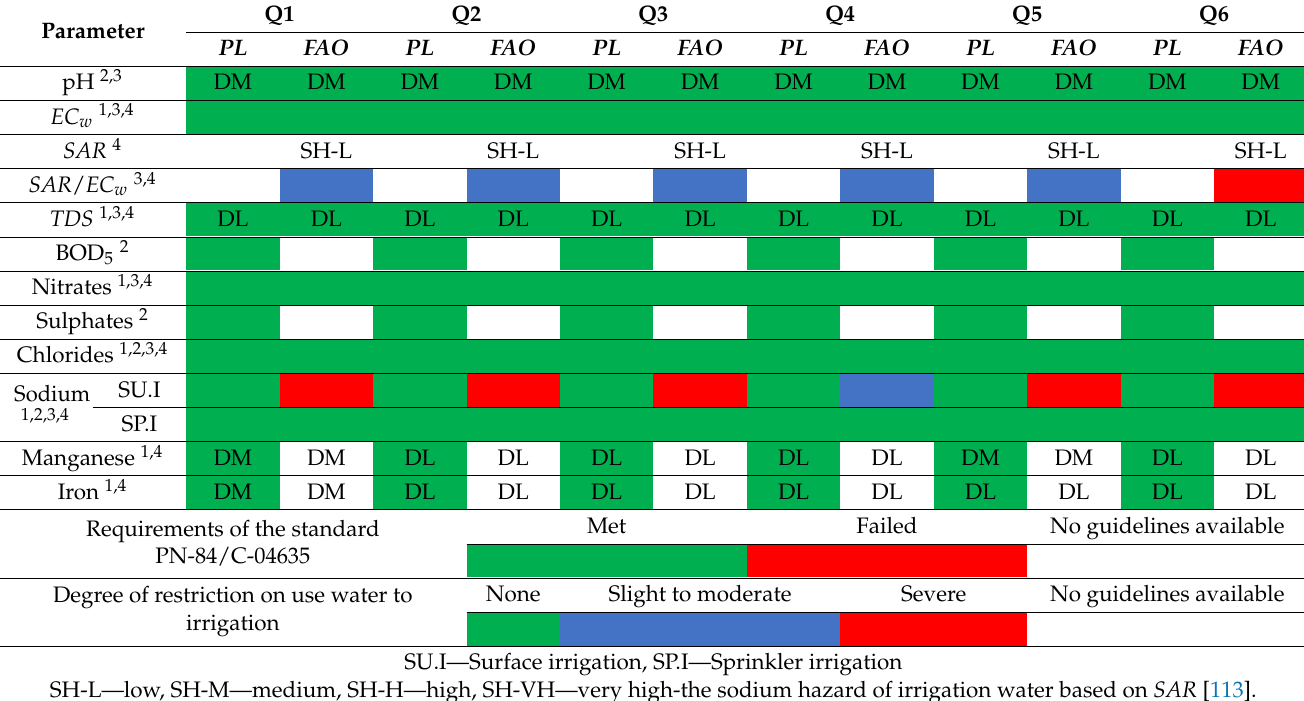
Table 5. Evaluation of the usability of quarry lake water for irrigation purposes (author